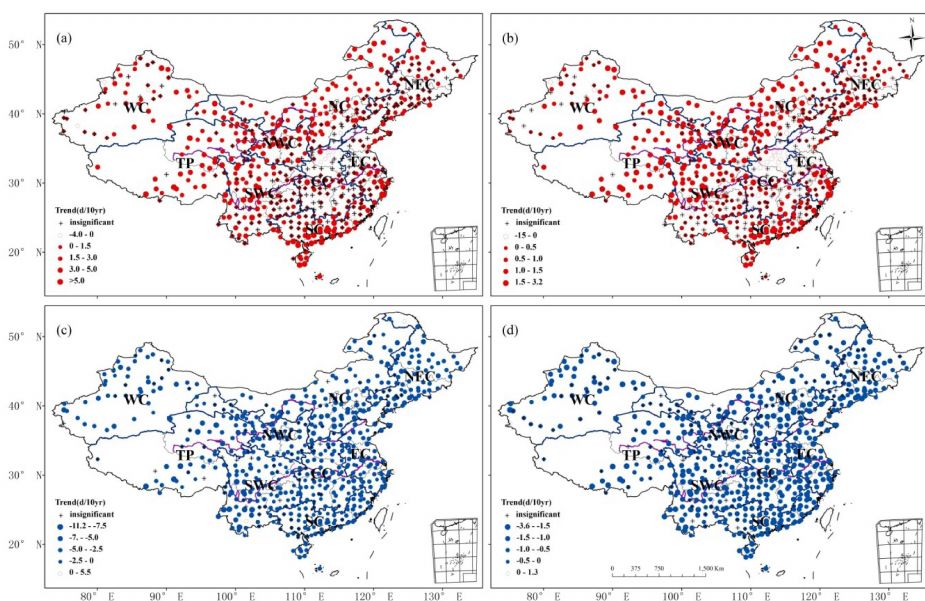
Figure 4. Spatial distributions of trends of extreme temperature indices in China during 1960–2010: ( a ) Trends of TX95p; ( b ) Trends of TX99p; ( c ) Trends of TN05p; ( d ) Trends of TN01p. The black symbol “+” shows the stations with trends that were insignificant at the confidence level of 0.05. The unfilled symbol “ ˝ ” represents increased frequency in TX95p and TX99p and decreased frequency in TN05p and